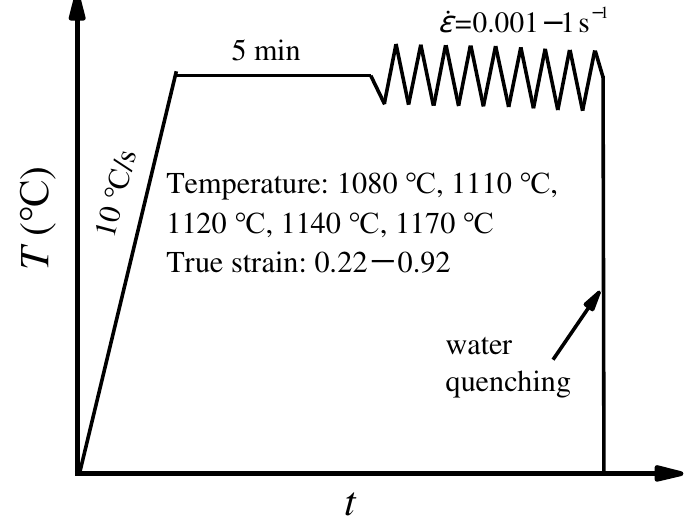
Figure 2. Schematic diagram of hot compression tests for the HIPed superalloy.